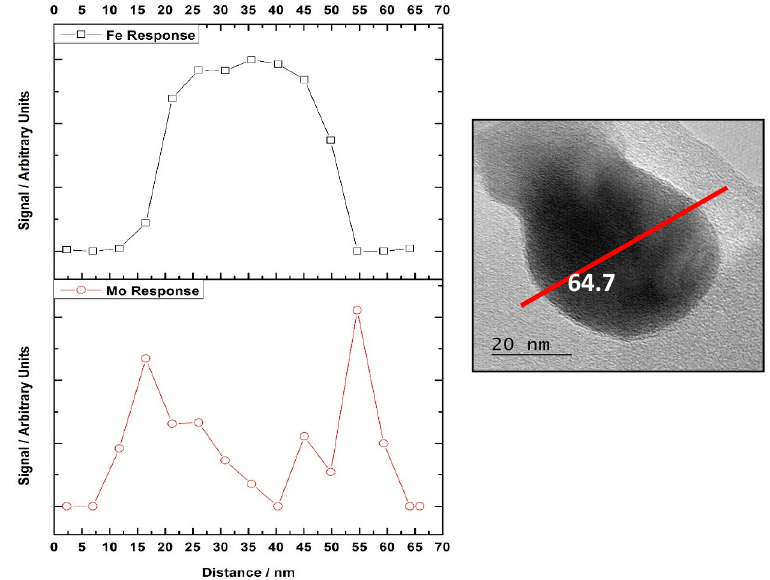
Figure 3. TEM image of a particle from 3ML MoO x /Fe 2 O 3 after a calcination at 500 °C with accompanying EDX line scan ( right ). Image adapted from C. Brookes et al., ACS Catal. , 2014, 4 (1), pp. 243–250 [16].